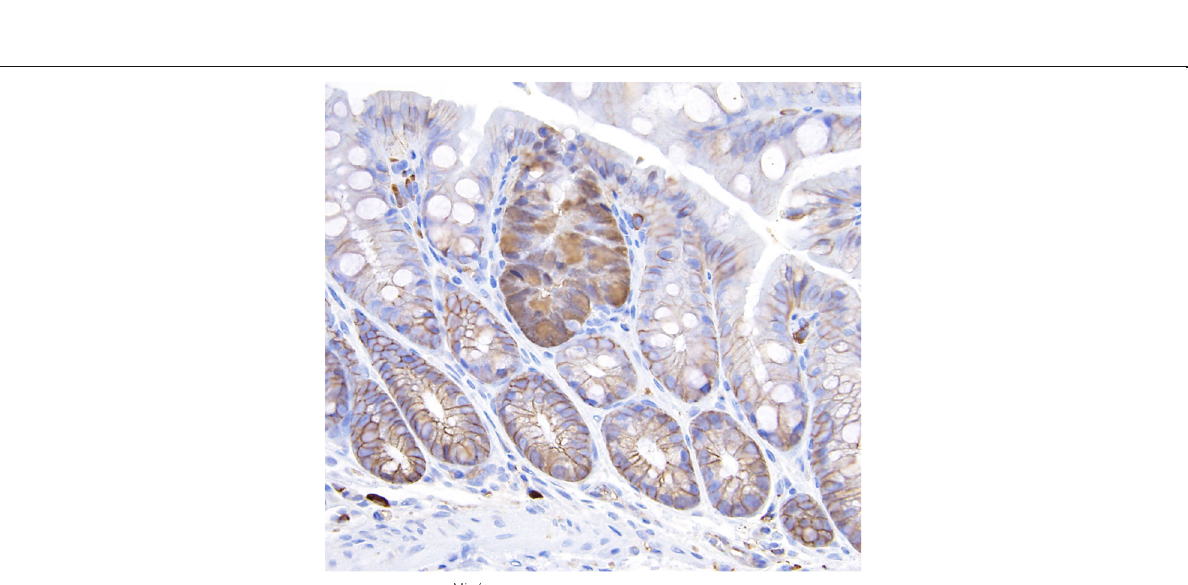
Fig. 4 Immunohistochemistry for beta catenin in Apc Min/+ and related models is useful in identifying small single crypt adenomas, which show loss of the normal membranous pattern and accumulation of beta catenin in the nucleus due to alterations in Wnt signaling